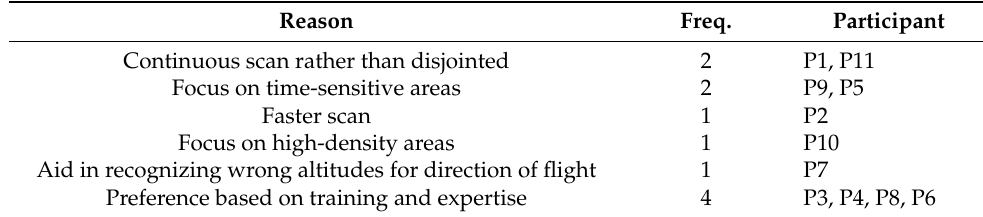
Table 3. Reason behind preferred visual search strategy.